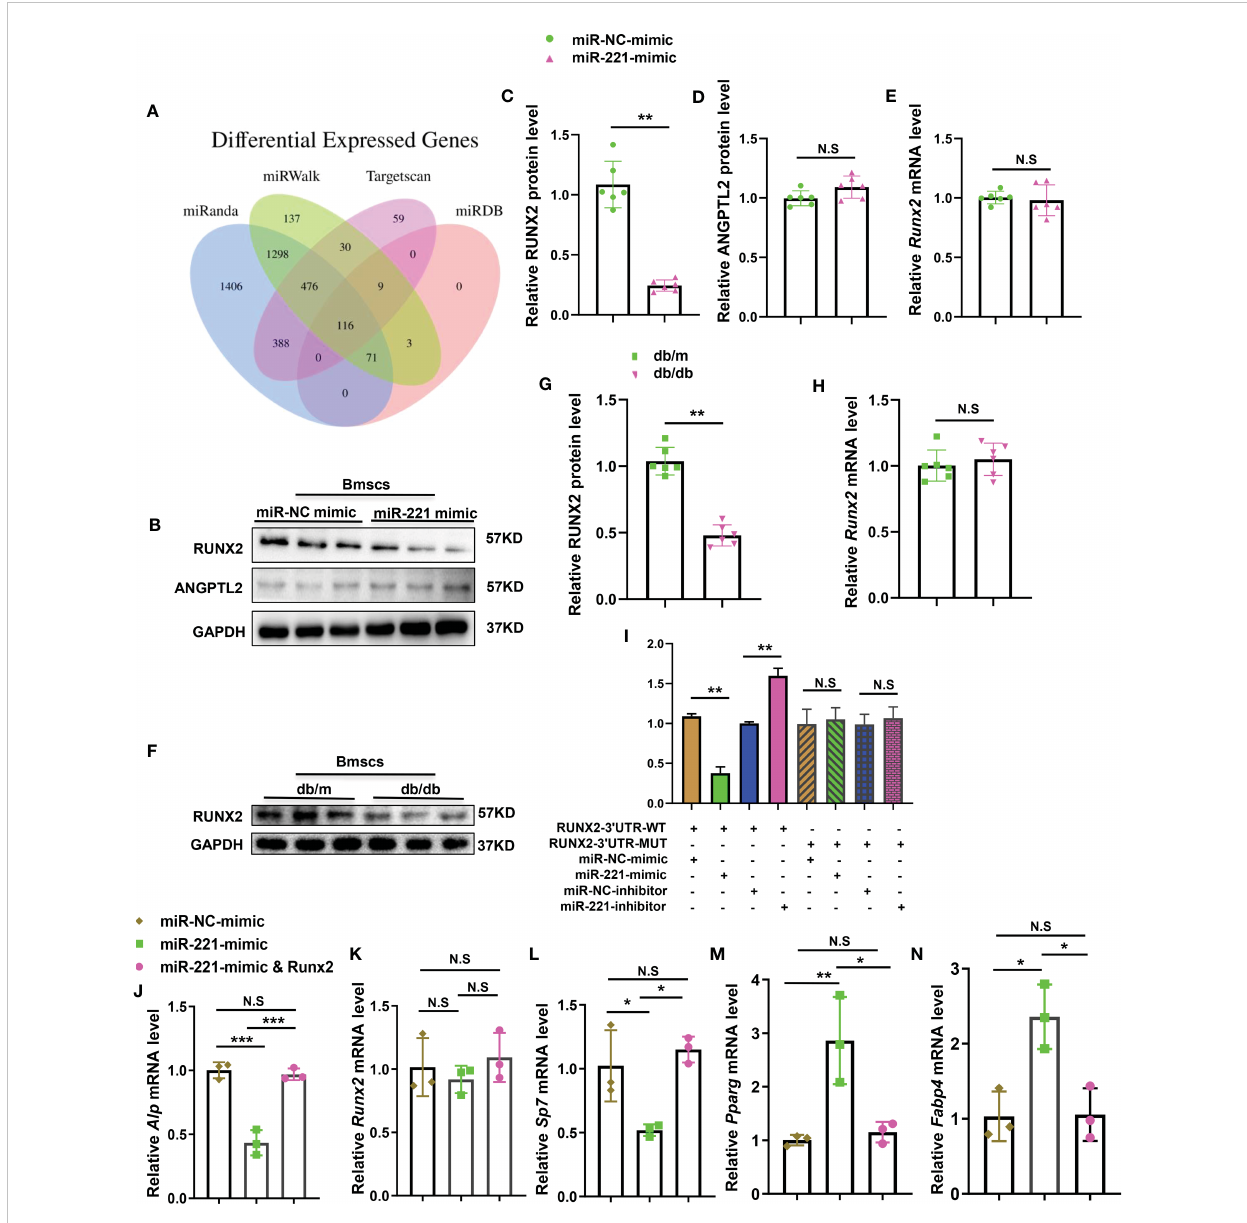
FIGURE 5 MiR-221 regulates osteogenesis and adipogenesis by direct targeting Runx2. (A) Bioinformatics tools (miRanda, miRwalk, targetscan and miRDB) were used to predict the targets of miR-221. (B) Representative Western blot image of 3 independent experiments in BMSCs transfected with miR- NC mimic and miR-221mimic, GAPDH was used as a loading control, full-length blots are presented in Supplementary Figure 2A-C, n=3 per group; (C, D) Quanti fi cation of the relative protein levels of RUNX2 (C) and ANGPTL2 (D) , n=6 per group; (E) Quanti fi cation of the relative mRNA levels of Runx2 in BMSCs transfected with miR-NC mimic and miR-221mimic, n=6 per group. (F-H) Extract primary BMSCs RNA and protein from normal and diabetic mice for quantitative analysis of RUNX2 expression; (F) Representative Western blot image of 3 independent experiments in normal and diabetic BMSCs, full-length blots are presented in Supplementary Figure 3A, B, n=3 per group; (G) Quanti fi cation of the relative protein levels of RUNX2, n=6 per group; (H) Quanti fi cation of the relative mRNA levels of Runx2 in normal and diabetic BMSCs, n=6 per group. (I) BMSCs were transfected with luciferase reporter carrying WT or MUT 3 ′ -UTR of the Runx2 gene, effects of miR-221mimic and miR-221inhibitor on the reporter constructs were determined at 48 hours after transfection. Quanti fi cation of relative luciferase activity of WT – Runx2 – 3 ′ -UTR, MUT – Runx2 -3 ′ -UTR respectively, n = 3 per group. (J-N) Transfected miR-221 and miR-221 together with Runx2 into BMSCs for 6 hours, then culture them in osteogenic induction medium and adipogenic induction medium for 3 days. Relative mRNA expression level of osteogenesis-related genes Alp , Runx2 and Sp7 , respectively (J-L) ; mRNA expression levels of adipogenic gene, Pparg and Fabp4 , respectively (M, N) ; NC, normal control, n=3 per group. The data is shown as the mean ± SD. * P <0.05, ** P <0.01, Student ’ s t-test is used in Figures C – H and ANOVA is used in Figures (I) NS, not signi fi